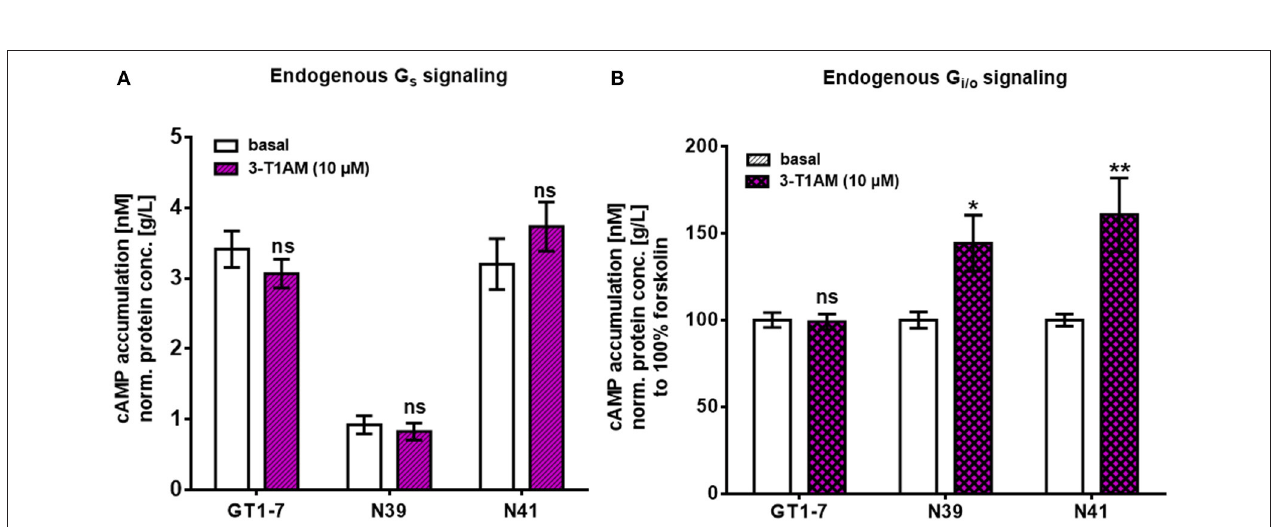
FIGURE 3 | 3-T1AM induces FSK-stimulated G α s signaling in murine hypothalamic cell lines. For G α s and G i / o, the cAMP content was measured via an AlphaScreen technology. Data are pooled from four independent assays measured in triplicates ( n = 4). For statistics a two-way ANOVA was performed, followed by a Sidak correction. Statistics were set to * p ≤ 0.05, ** p < 0.01. (A) Cells were stimulated with stimulation buffer or 3-T1AM in a concentration of 10 − 5 M for 45min ( n = 4 ) . (B) Cells were co-stimulated with 50 µ M FSK and either stimulation buffer or 3-T1AM (10 µ M) for 45min ( n = 4).